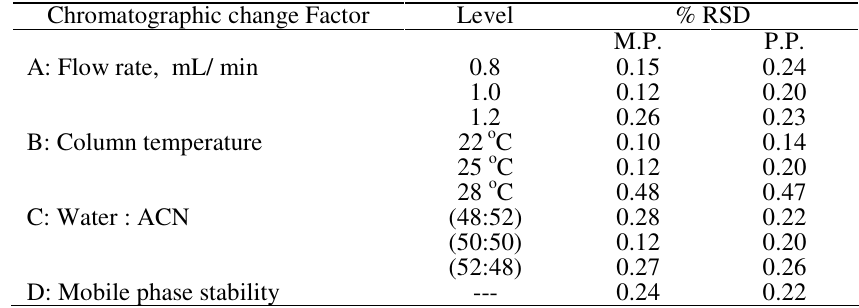
Table 3. Robustness evaluation of proposed HPLC